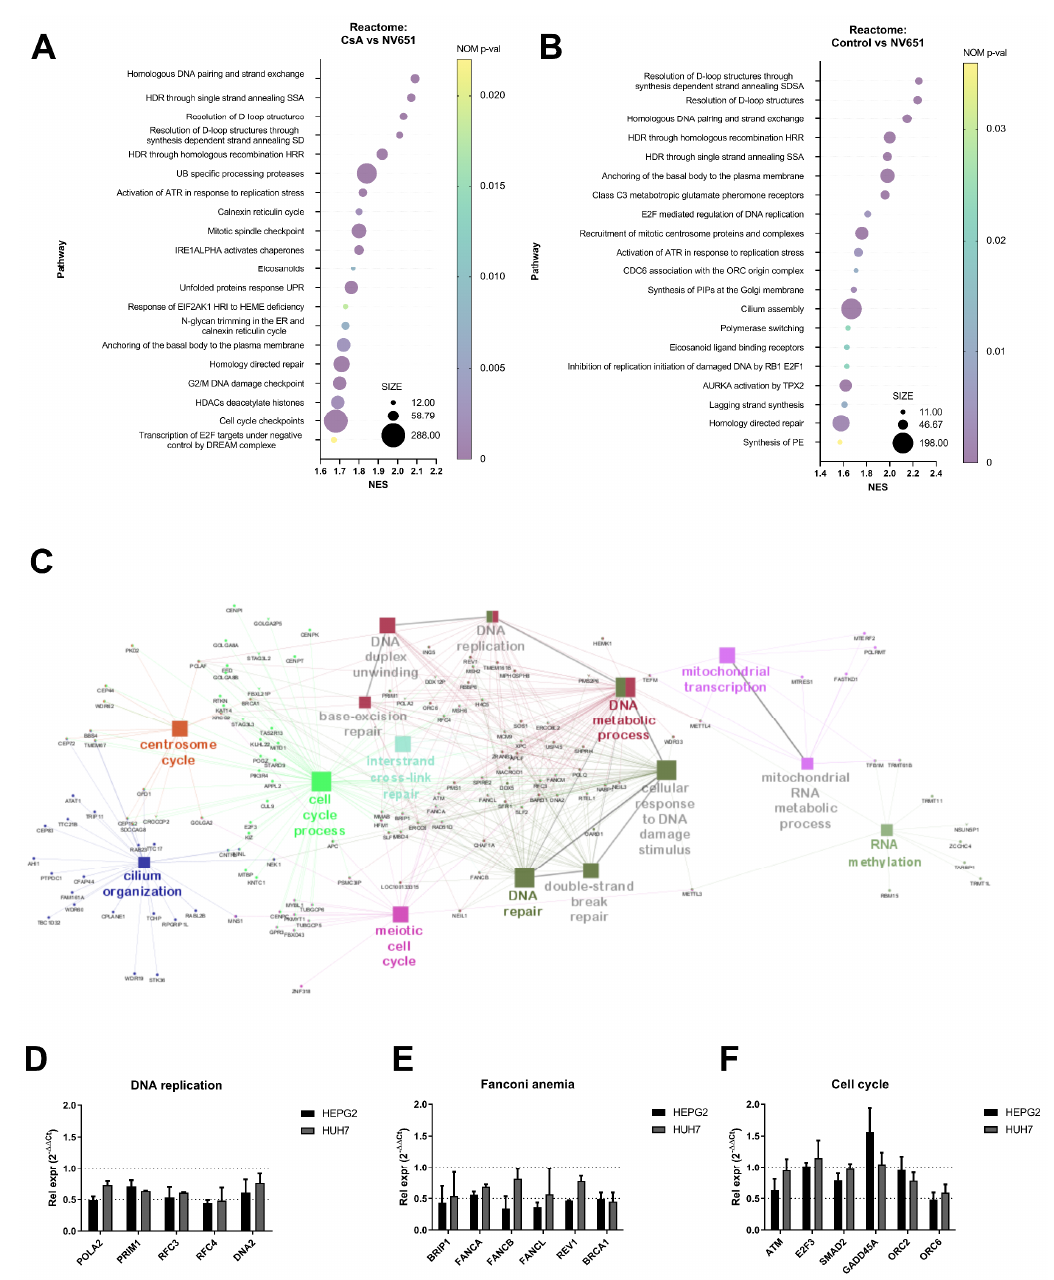
Figure 2. NV651 effect on gene expression. ( A – C ) Transcriptome was analysed after 4 h of 500 nM NV651, CsA or control treatment in HEPG2 cells. ( A , B ) Top 20 genes sets for GSEA in the reactome for CsA versus NV651 ( A ) and control versus NV651 ( B ). ( C ) Cytoscape with the GO biological process at an intermediate level (3–8) with the significant genes indicated (kappa score ≥ 0.4). ( D – F ) NV651’s effect on gene expression after 4 h of exposure in HEPG2 and HUH7 cells. mRNA levels of the indicated genes were analysed by qPCR. Data in ( D , F ) are presented as the mean ± SD of the relative expression in n = 2 biological replicates.